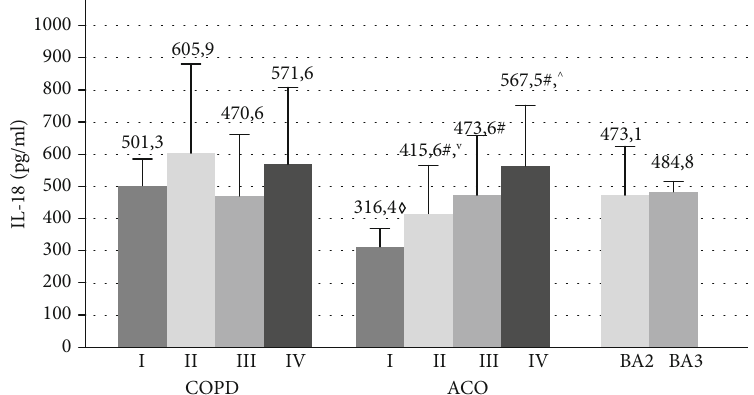
Figure 5: The serum concentrations of IL-18 in patients with COPD, ACO, and BA with varying severity of disease and airway obstruction. COPD: chronic obstructive pulmonary disease; ACO: asthma-COPD overlap; BA: bronchial asthma; I: GOLDI, ACOI; II: GOLDII, ACOII; III: GOLDIII, ACOIII; IV: GOLDIV, ACOIV; BA2: moderate bronchial asthma, BA3: severe bronchial asthma; # p < 0 : 05 versus patients with ACOI; ^ p < 0 : 05 versus patients with ACOII and ACODIII; ◊ p < 0 : 05 versus patients with GOLDI; ∨ p < 0 : 05 versus patients with GOLDII.